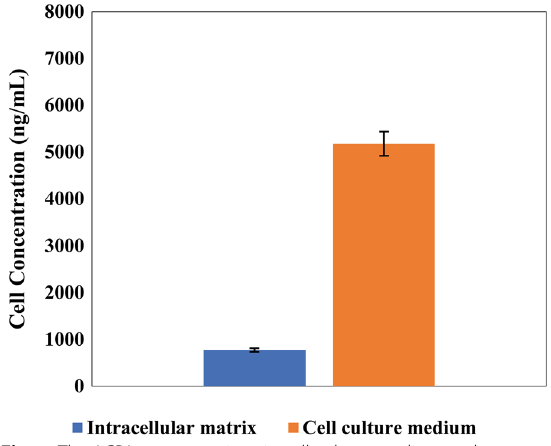
Fig. 4 The ACPA concentrations in cell culture medium and intracellular matrix of L929 mouse fibroblast cells line samples (